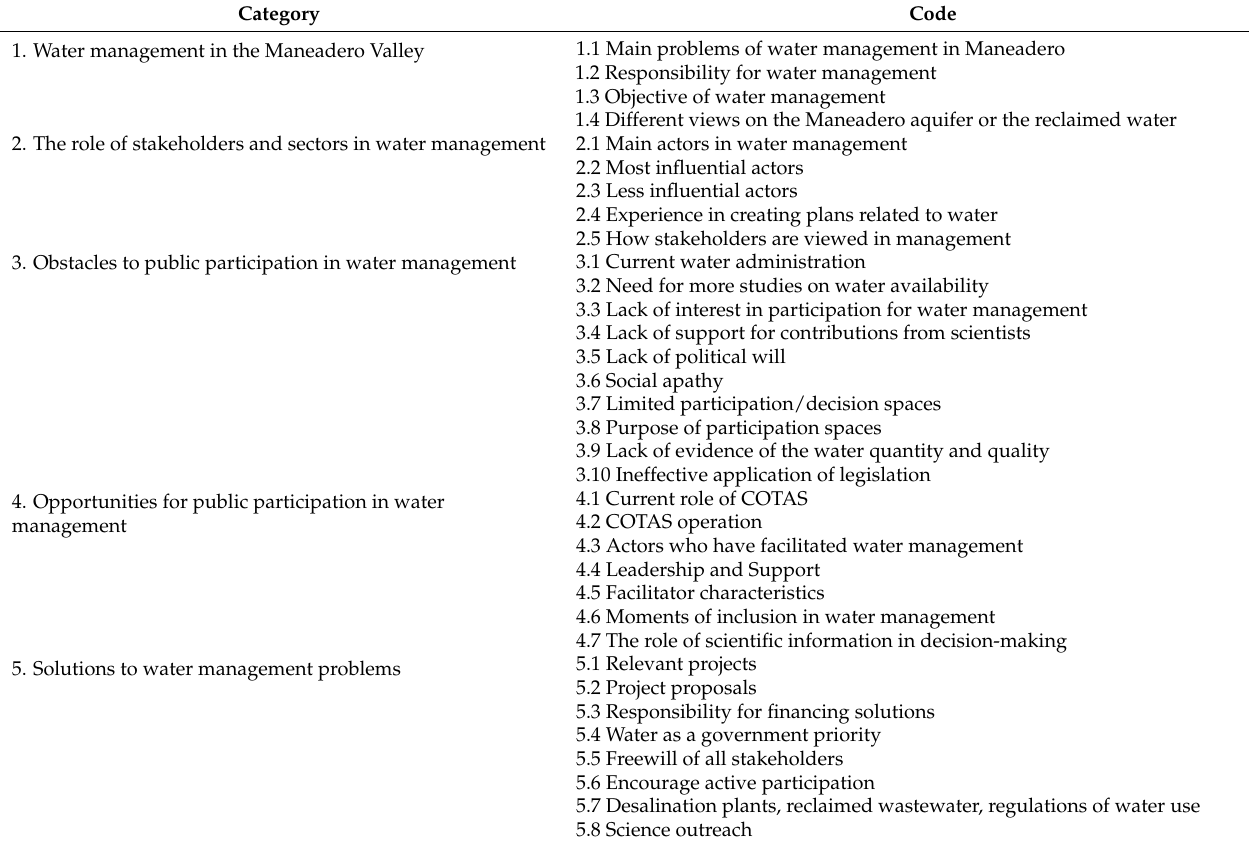
Table 3. List of categories and